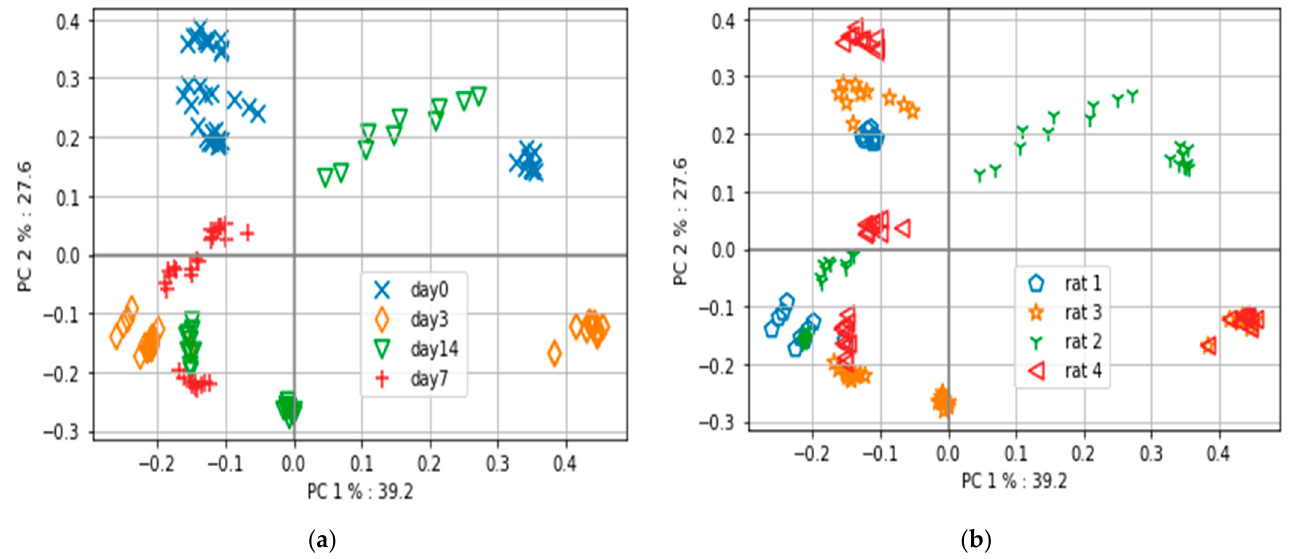
Figure 4. In vivo PCA results. Optical data are collected from rats referred to as 1, 2, 3, and 4 on days 0, 3, 7, and 14: ( a ) PCA plot based on different days; ( b ) PCA plot based on different rats.